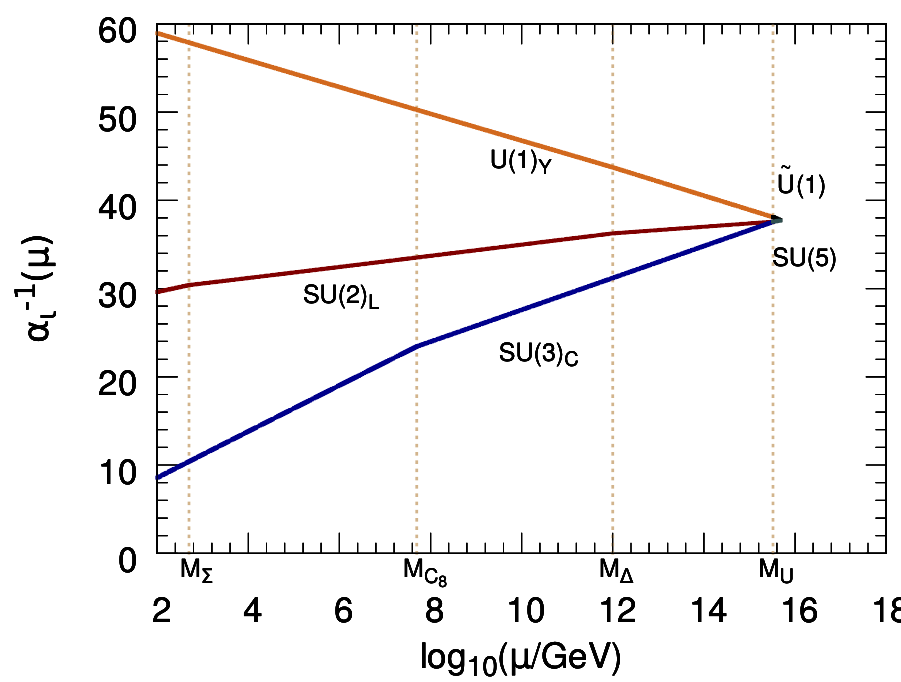
Figure 14 . Uni(cid:12)cation of couplings of the SM gauge group SU(3) C (cid:2) SU(2) L (cid:2) U(1) Y in the presence of LH triplet scalar (cid:1) L , the triplet fermionic dark matter (cid:6) F , and the color octet fermion C 8 as described in the text. The ordinates corresponding to these masses M (cid:6) ; M C GUT scale M U are indicated along the